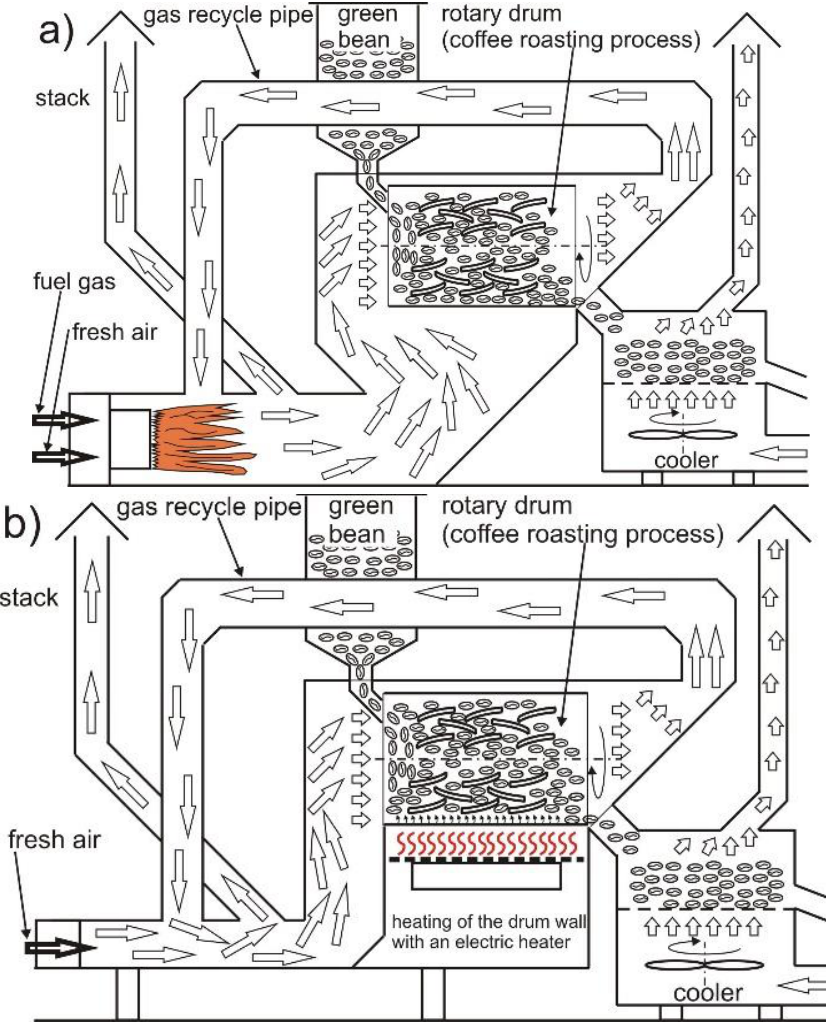
Figure 1. Scheme of the coffee roasting process in the convection–conduction roaster (CC)—( a ); scheme of the coffee roasting process in the convection–conduction–radiation roaster (CCR)—( b ).